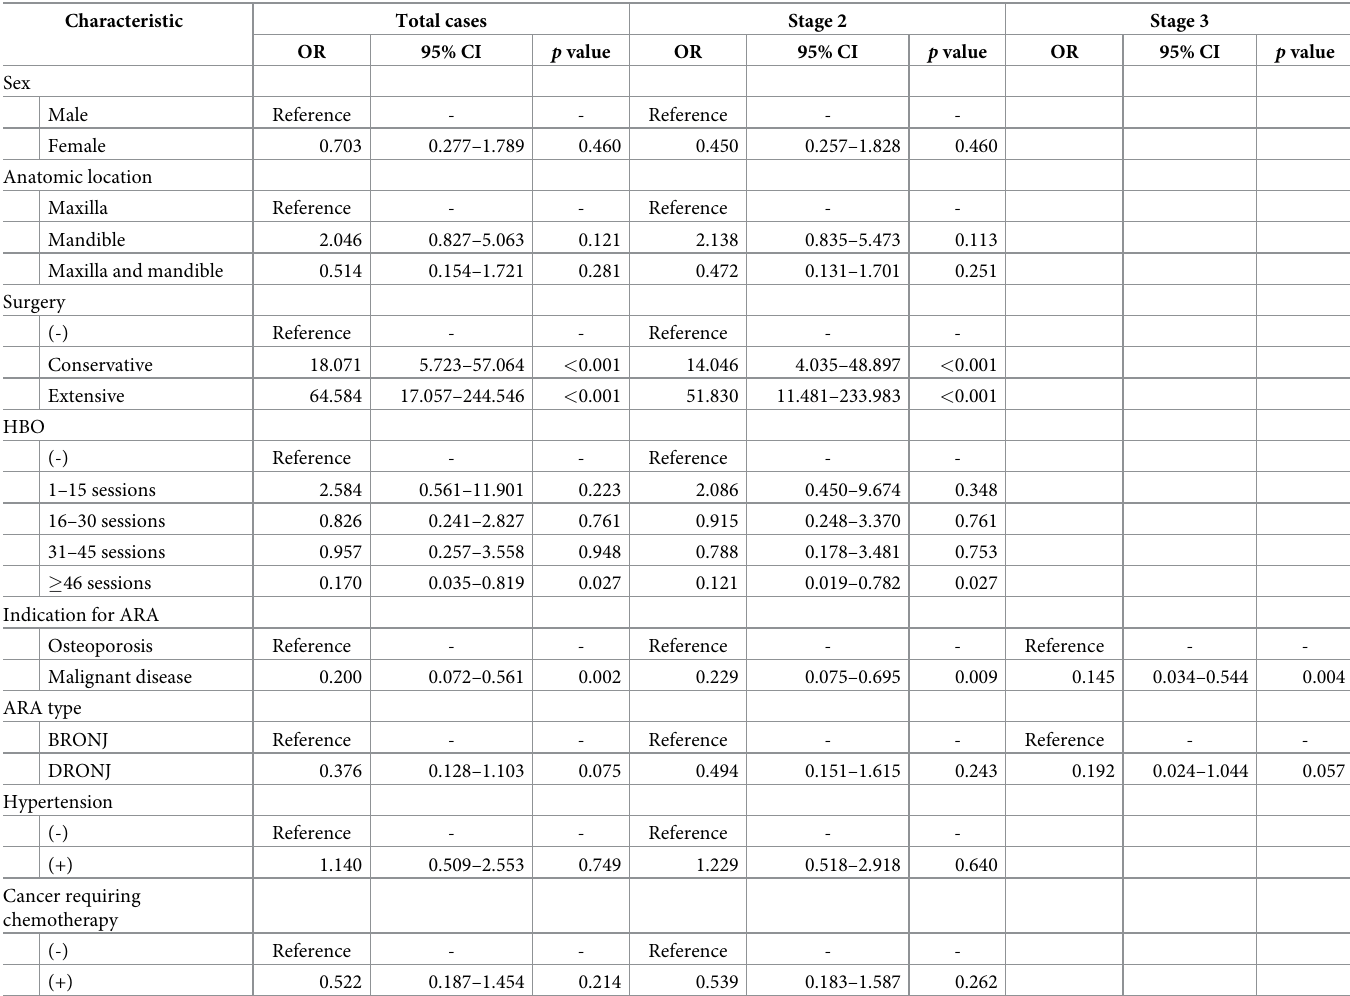
Table 5. Multivariable logistic regression analysis of variables relating to healed